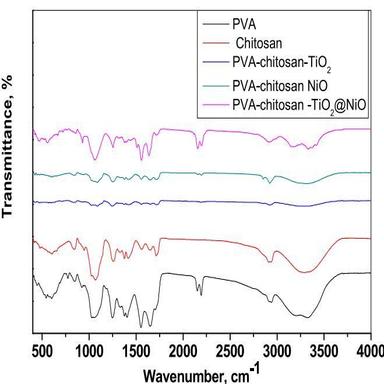
IR spectra of PVA, chitosan, PVA-chitosan–TiO2, PVA-chitosan–NiO, and PVA-chitosan–TiO2@ NiO films.